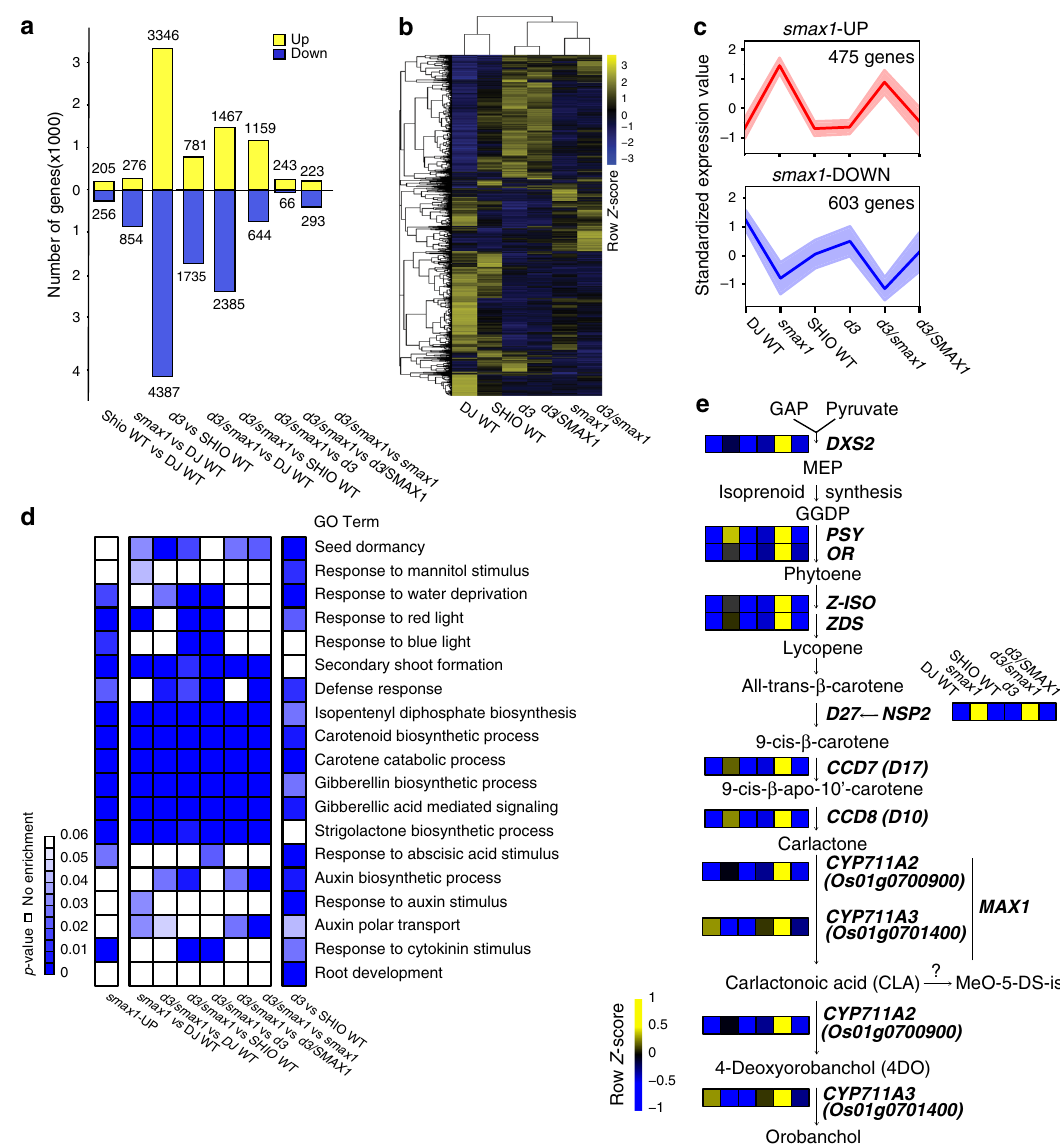
Fig. 3 Transcriptome analysis of mock-inoculated mutant and wild-type rice genotypes. a Overview over the number of differentially expressed genes ( p -value ≦ 0.05, fold-change ≥ |2 | ) in pairwise comparisons as indicated. b Hierarchical clustering of 11,674 genes differentially expressed (FDR adjusted p ≦ 0.05, fold-change ≥ |2 | ) in at least one pairwise comparison was generated according to the Pearson correlation. The median expression values of genes from biological replicates were z-score normalized to have the mean of 0 and standard deviation (SD) of 1 across genotypes samples. (black: mean, blue: downregulated, yellow: upregulated). c Clustering of up (red) — and down (blue) -regulated genes in either smax1 or smax1/d3 by fuzzy c-means clustering. Graph shows a representative clustering pattern. Red and blue lines indicate the median expression value of all the genes in the cluster and the shadowed region indicates ±SD from median. The x and y -axis denote genotypes and the z-score normalized expression value. d Gene Ontology (GO) enrichment analysis of smax1 - or d3/smax1 -, upregulated genes from the pairwise comparisons. The enrichment rate is shown in p -value scale (<0.05), where lower values indicate stronger enrichment. e The metabolic pathway of the strigolactone biosynthesis pathway. Genes that are upregulated in either smax1 or smax1/d3 were selected and the normalized expression values across six genotypes were color coded according to z-score. GAP glyceraldehyde 3